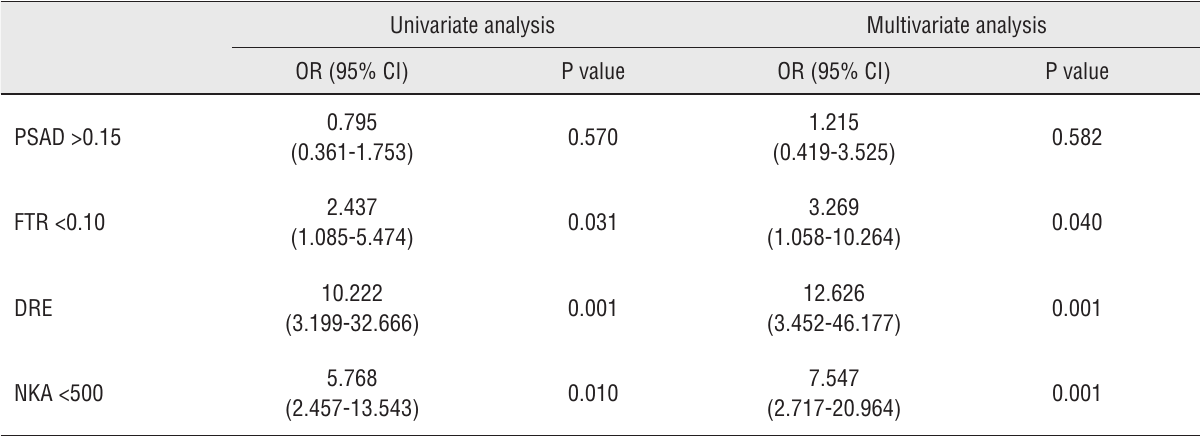
Table 4 - Univariate and multivariate analyses of parameter for predicting prostate